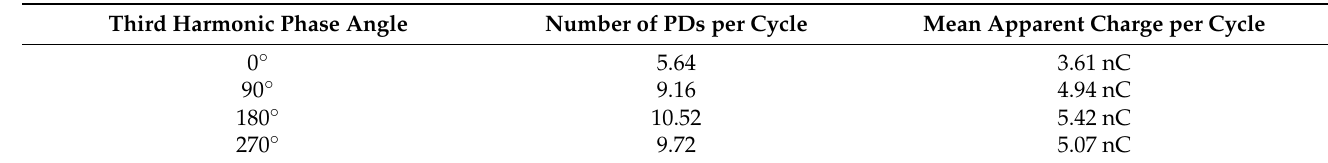
Figure 15. Simulated results for the case wherein a voltage distorted by the 3rd harmonic component with ϕ h = 270 ◦ and THD = 20% was applied: ( a ) electric fields over time; ( b ) PDs current pulses. Table 2. PDs’ simulated results for different 3rd harmonic phase angles with THD =